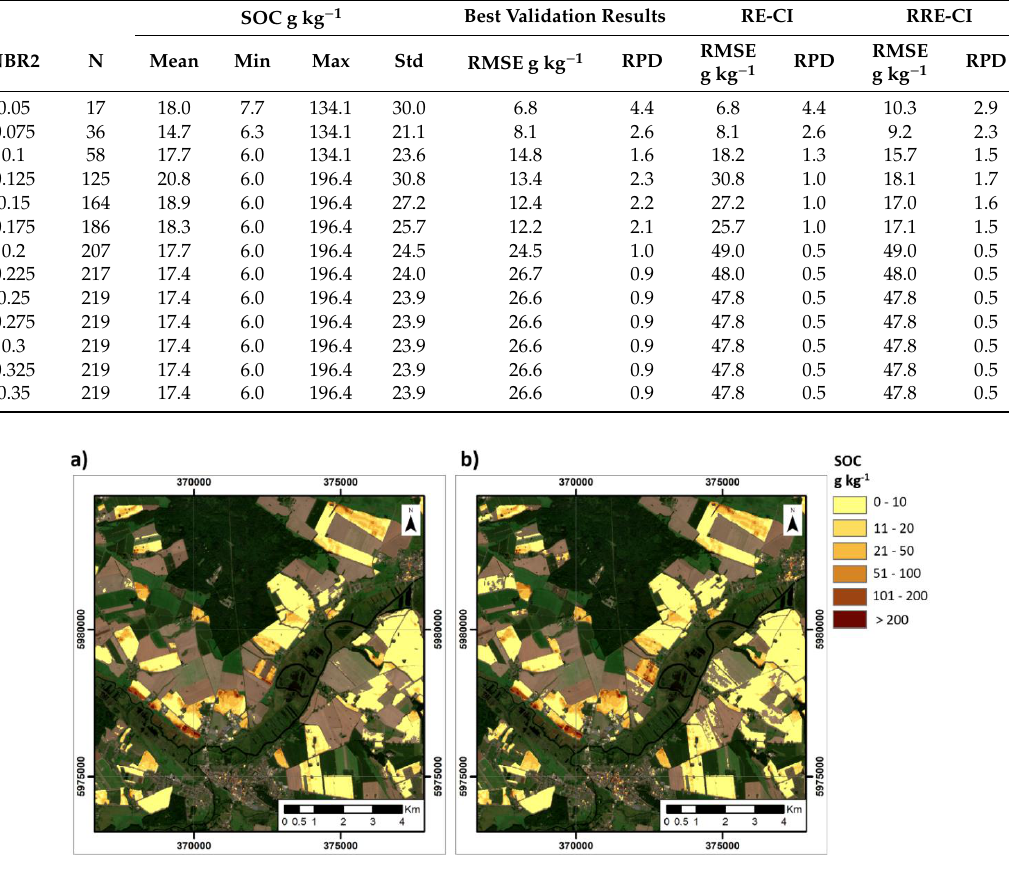
Figure 8. Zoom on a restricted area of the soil organic carbon maps obtained applying the Red-Edge Carbon Index RE-CI model to the pure pixels selected using a Normalized Burn Ratio 2 (NBR2) threshold of 0.05 ( a ) and 0.075 ( b ). The RGB (red: 665 nm, green: 560 nm, blue: 490 nm). Sentinel-2 image acquired on 30 August, 2017 was used as background. Coordinates are in the WGS 84 / UTM zone